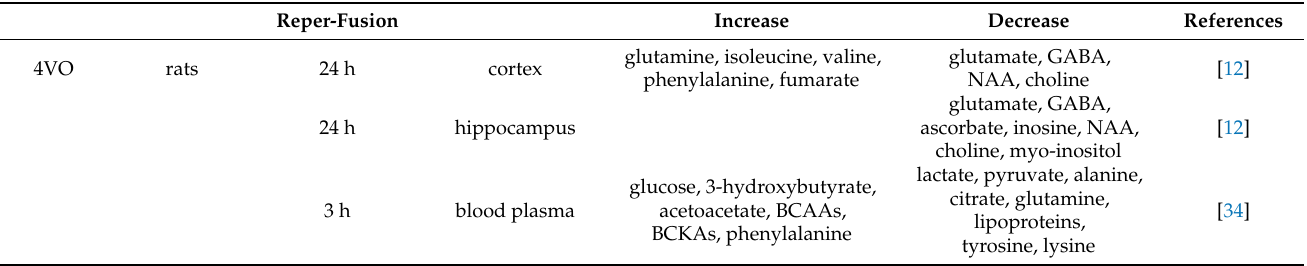
Table 1. Metabolomic changes in tissues and blood plasma in different animal models of cerebral ischemia by in vitro 1 H NMR metabolomic approach